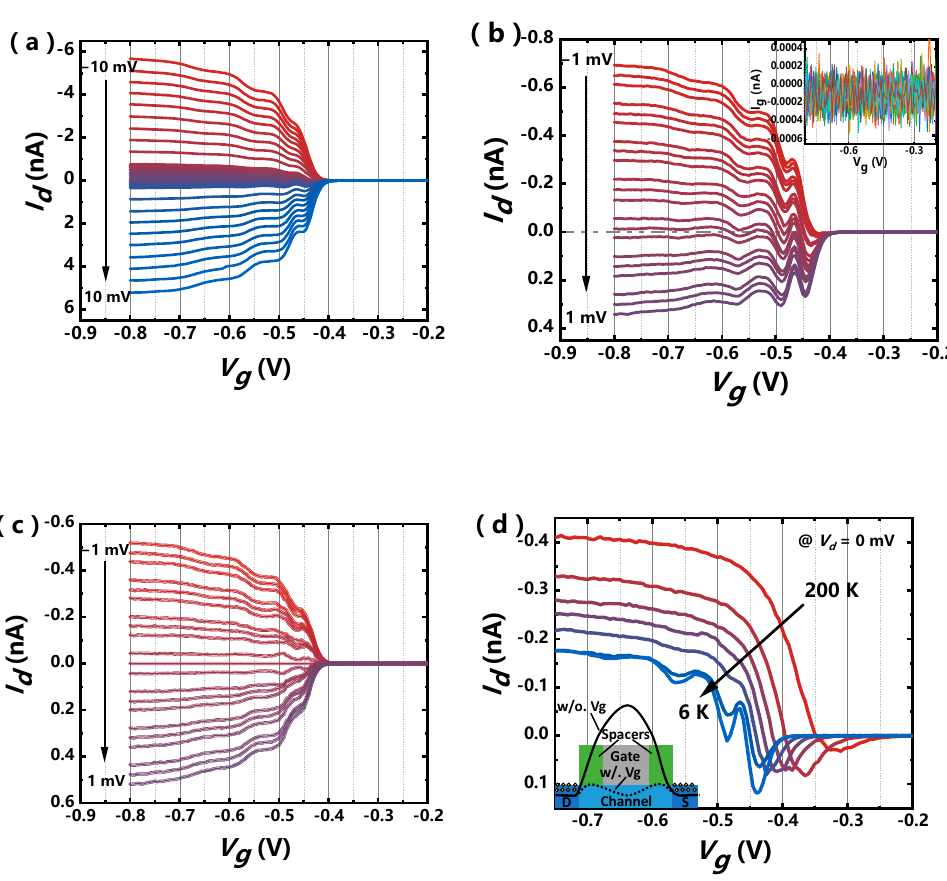
Figure 7. ( a ) Measured I d –V g curves at different V g s ranging from − 10 mV to 10 mV and ( b ) from − 1 mV to 1 mV at 6 K. Inset: gate current I g as function of V g . ( c ) The I d –V g curves at different V g by subtracting the drain zero-bias current. ( d ) Temperature dependence of zero-bias drain current with gate voltage. Inset: Electrostatic potential distribution by applying gate voltage (dotted line) or without gate voltage (solid line).